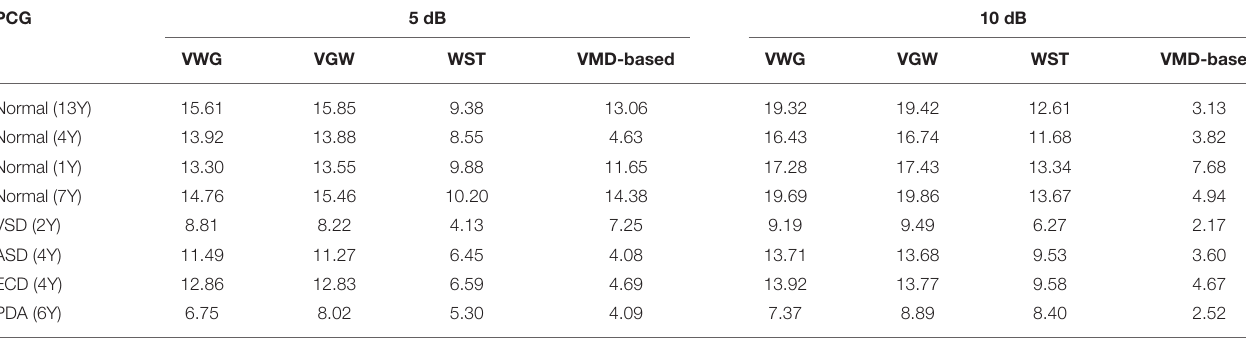
TABLE 2 | Comparison of signal-to-noise ratio (SNR) of PCG signals with Gaussian noise after noise reduction. PCG